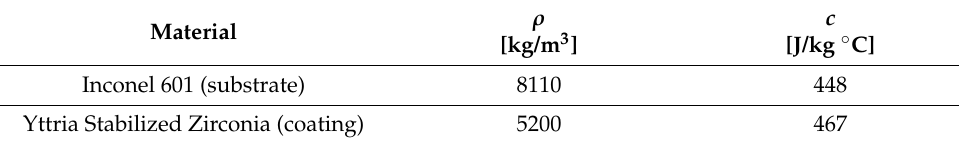
Figure 6. SEM images: ( a , b ) APS samples; ( c , d ) SPS samples. Table 1. Physical characteristics of